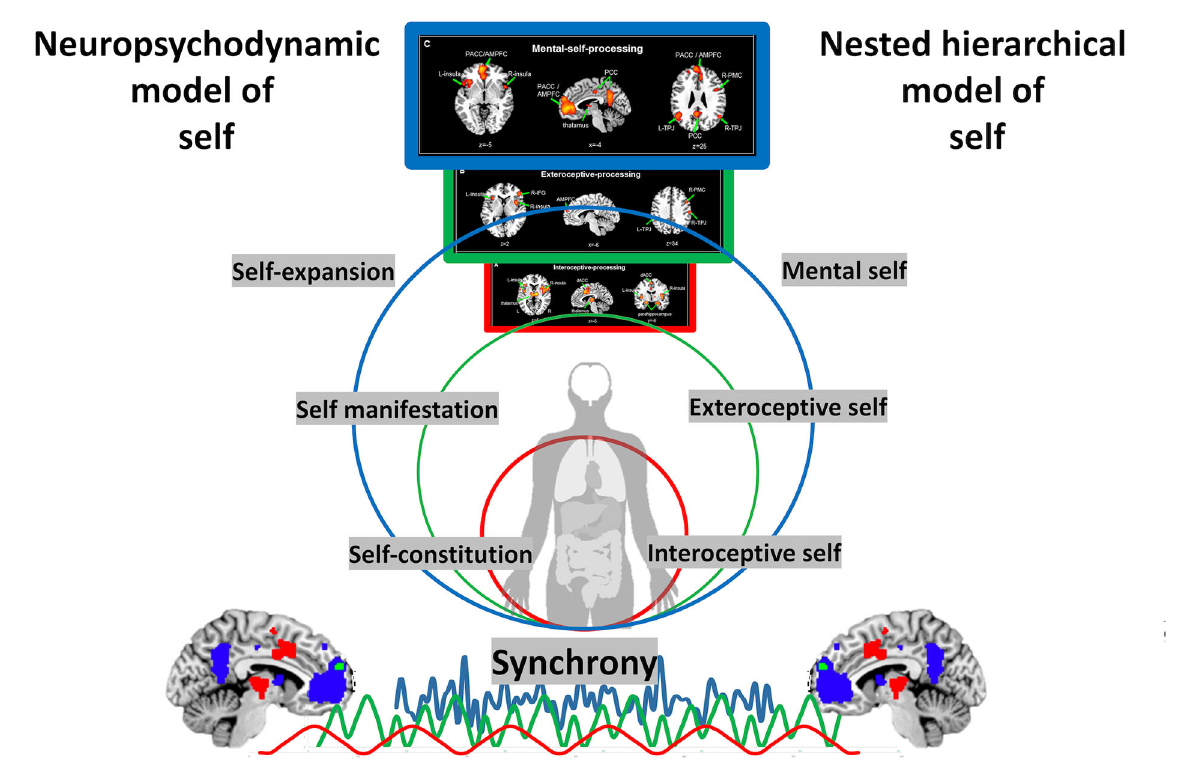
FIGURE4 Conjunction of the neuropsychodynamic model of self and nested hierarchical model of self. Self-constitution, as related to the layer of interoceptive self, is linked with the ownership of one’s own body, sense of agency and the capacity to distinguish the self from the non-self and the internal from the external (i.e., reality testing). Self-manifestation, as related to the layer of exteroceptive self, is particularly featured by the degree of integration of the self and significant others and by the actual experience and manifestation of the self with the external world. Finally, Self-expansion, as related to the layer or mental self, is characterized by the capacity to self-expand and bind the different information of various aspects of self and other into perception and